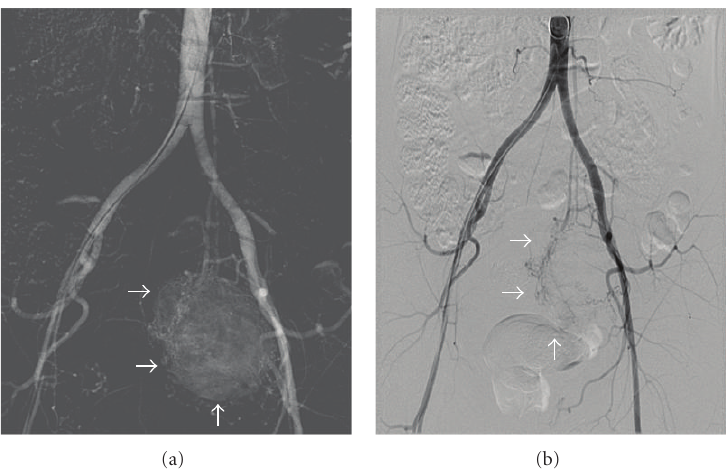
Figure 4: Angiography before and after TAE: tumour traces decreased in the target lesion after TAE.